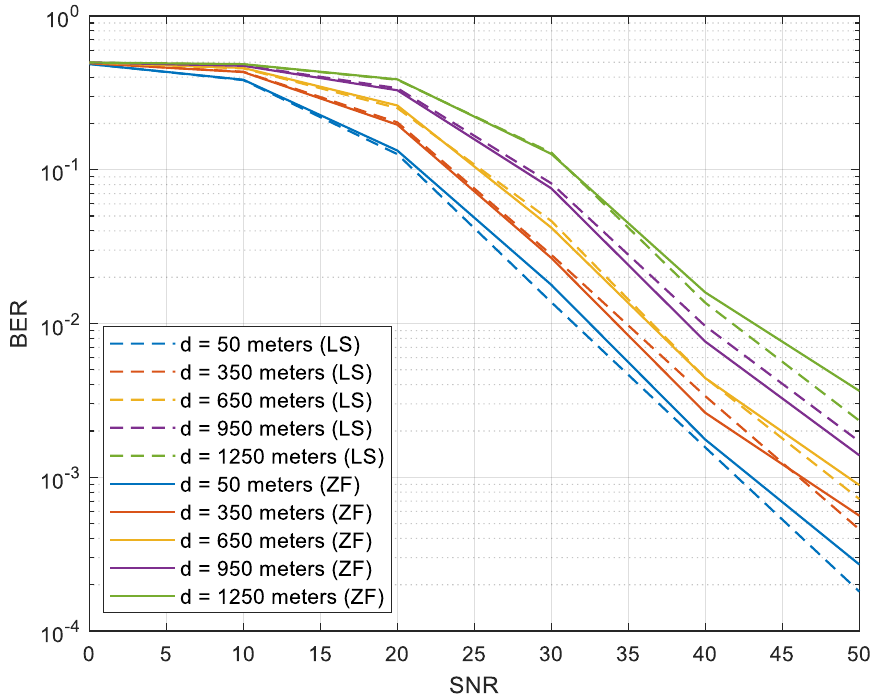
Figure 7. BER of CP-OFDM when using the LS and ZF equalizers as a function of the transmitter- receiver distance with 64 subcarriers and 16